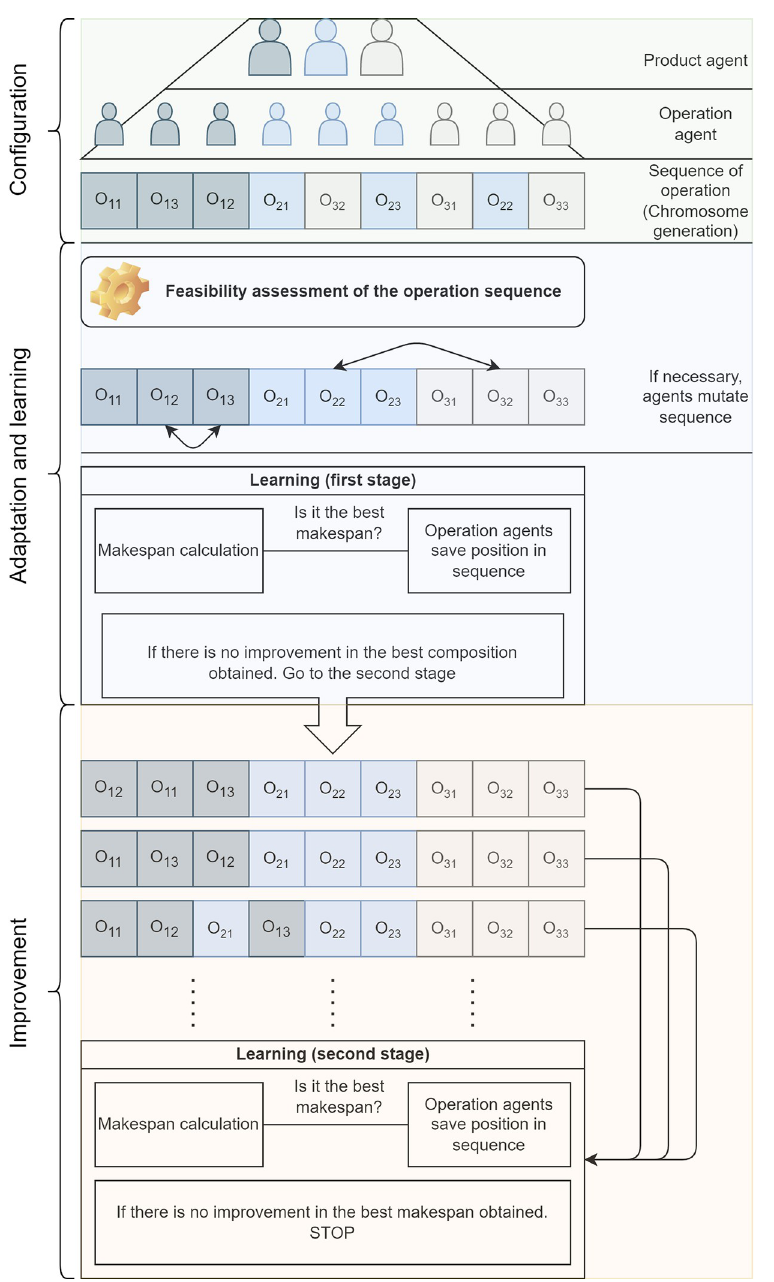
Fig 1. Execution procedure of the proposed approach.